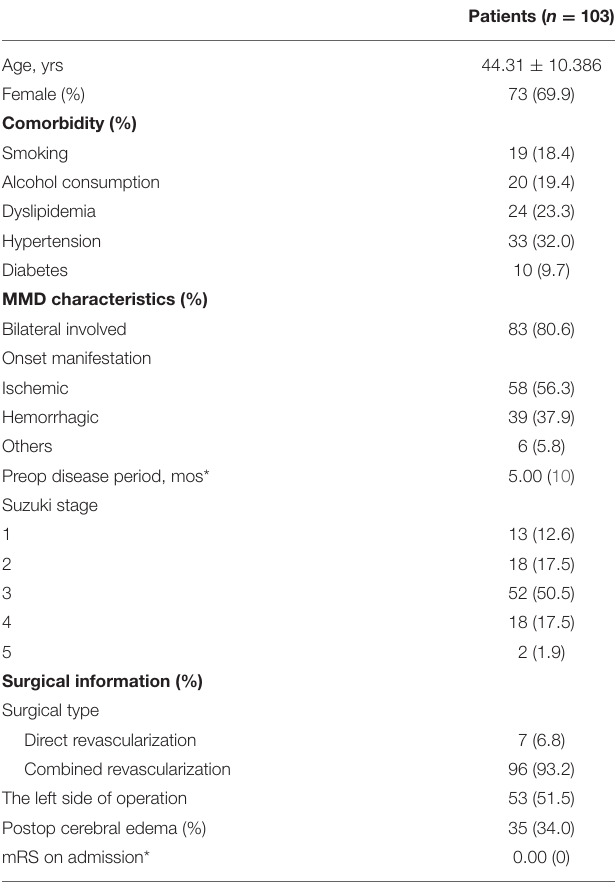
TABLE 1 | The baseline characteristics of enrolled MMD